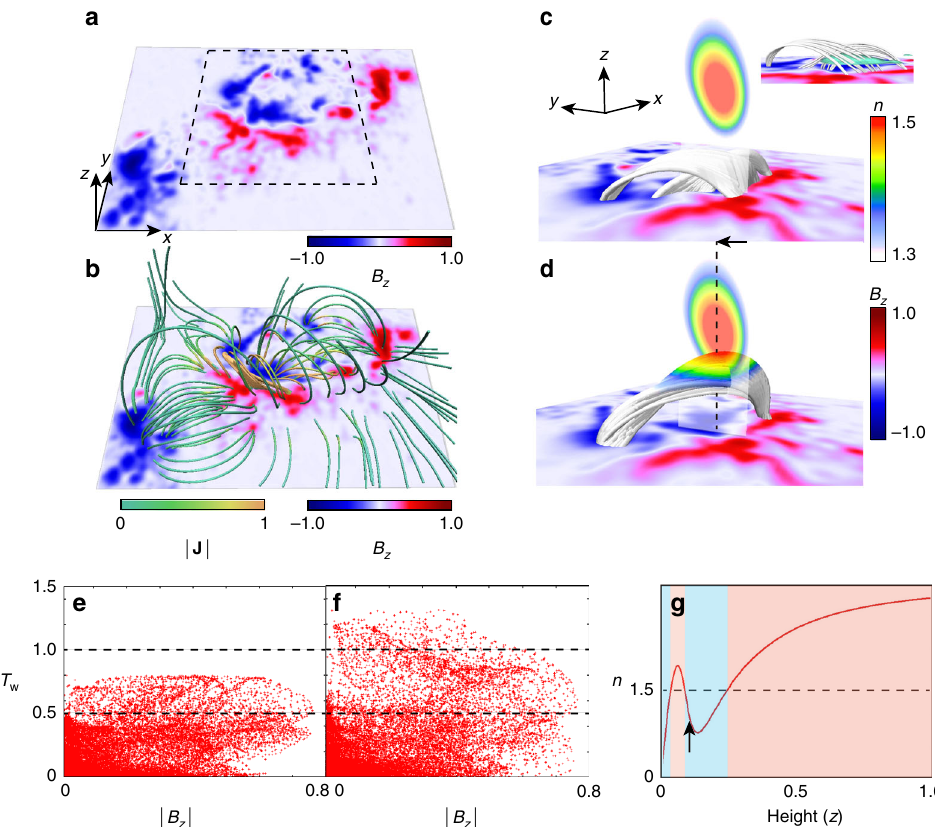
Fig. 3 Stability of the magnetic fi elds before and after the tether-cutting reconnection. a Photospheric magnetic fi eld ( B z ) of AR11158 taken by SDO/HMI observed at 16:00 UT on February 13, corresponding to 90 min approximately before the M6.6-class fl are. The NLFFF and twist are calculated only from the region surrounded by the dashed-square in the range of 0.38 L * ≥ x ≥ 0.65 L * and 0.38 L * ≥ y ≥ 0.65 L *, where the outside of the boundary is fi xed by the potential fi eld. b Three-dimensional fi eld lines of the NLFFF, which are represented with the current density | J | . c The fi eld lines of the NLFFF, which focuses on the twisted lines enhanced with | J | in b . The color of the fi eld lines and vertical cross section corresponds to the decay index. The small inset shows the side view with green isosurface of | J | = 30. d The fi eld lines after the tether-cutting reconnection. e , f Twist ( T w ) distribution of the NLFFF and a state after the tether-cutting reconnection, depending on | B z | measured at each footpoint of the fi eld lines. g The decay index depending on the height measured along the vertical dashed line in d , where the horizontal dashed line marks n = 1.5. Red and blue regions indicate the unstable and stable those to the torus instability, i.e., a fl ux tube loses the equilibrium in a region marked in red. The arrow points out the height which is same one marked by the arrow in